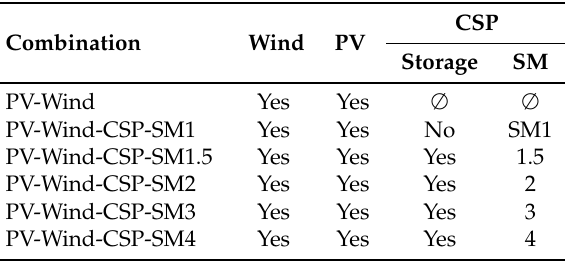
Table 1. Optimization